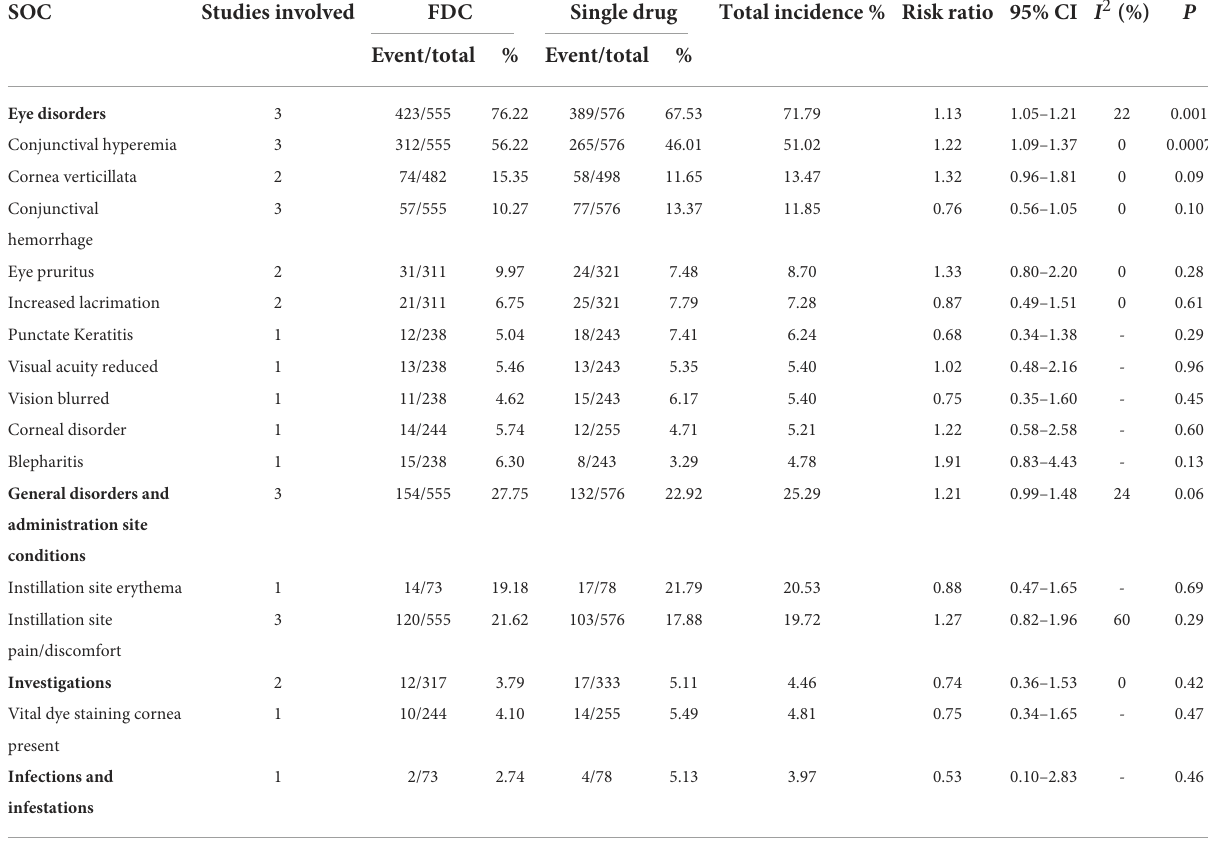
TABLE 3 Comparison of adverse events grouped by SOC between Netarsudil/Latanoprost FDC and